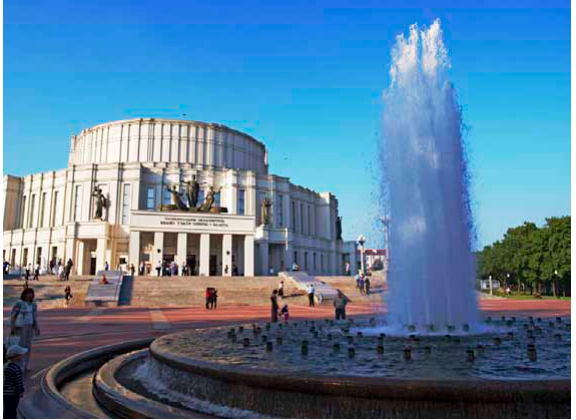
fig. 14. Palace of the opera ir Ballet Theater in Minsk. D. Ma- čiulis